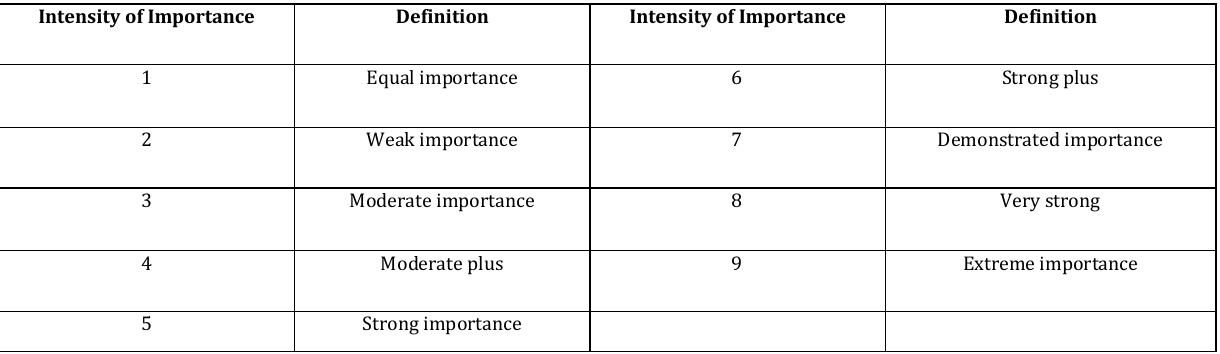
Table 2: Scale of relative importance